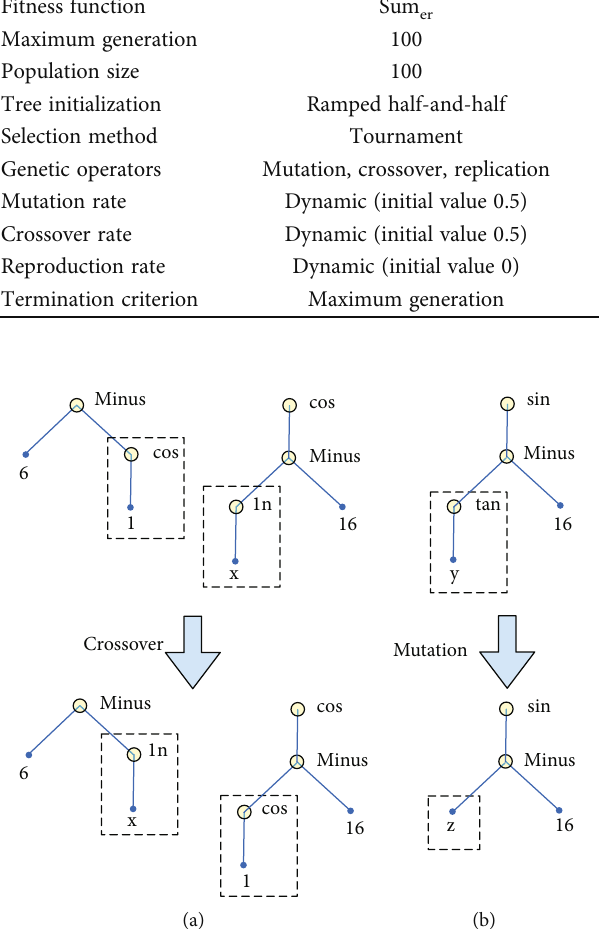
Figure 4: Schematic diagram of individual (a) crossover and (b) mutation.